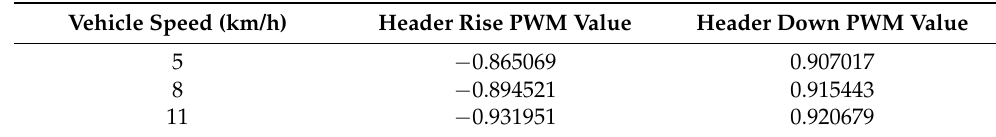
Table 5. Correlation test between PWM and header height.